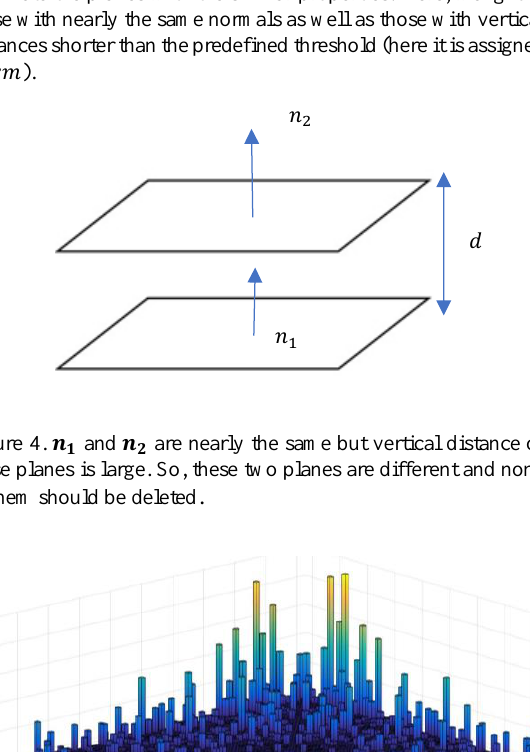
Figure 6. Intersection of 9 planes with the point cloud, considering 700 inliers in RANSAC